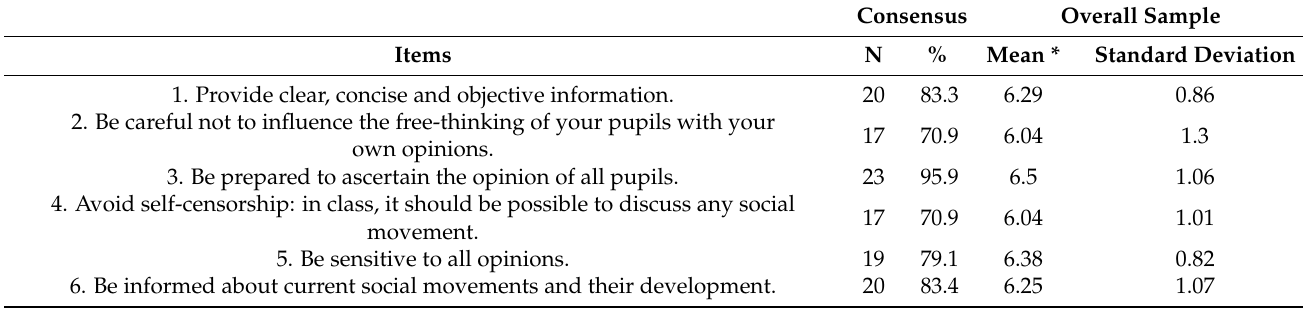
Table 2. Category B. Recommendations for helping primary schoolteachers tackle the issue of social movements.